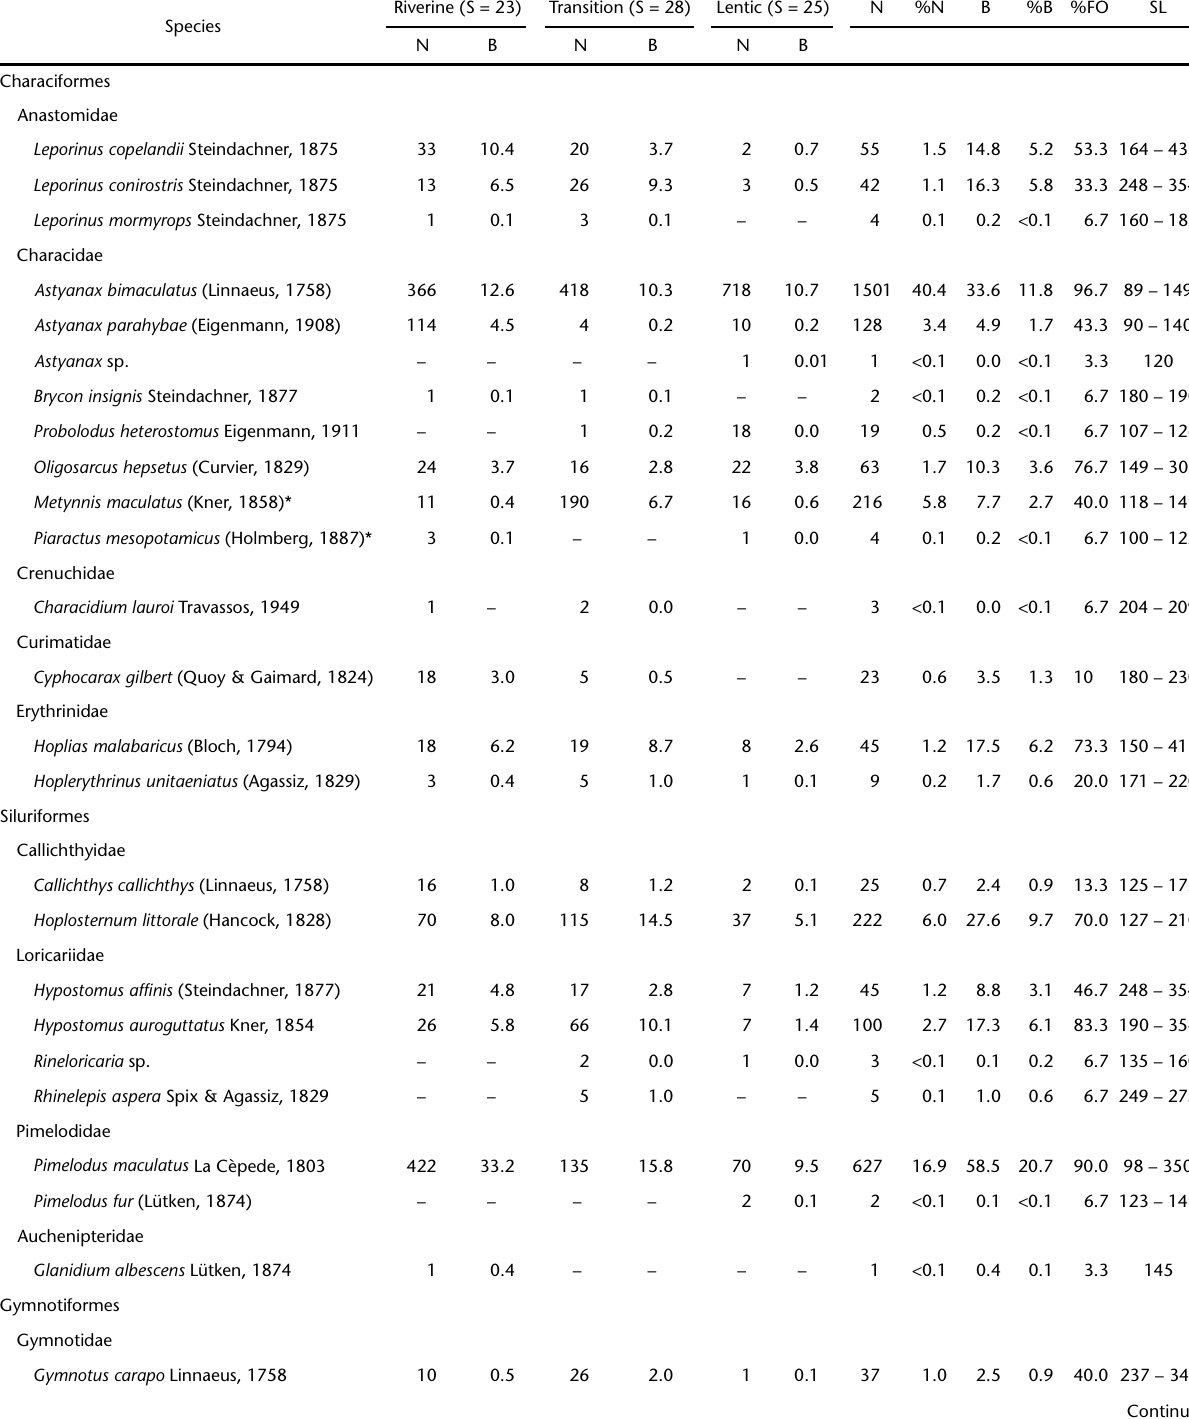
Table I. Number of specimens (N), standard length range (SL, in mm), total biomass (B, in kg) and frequency of occurrence (FO) of the fish sampled in the Paraíba do Sul River – Funil reservoir system (*, non-native species). S = species richness.